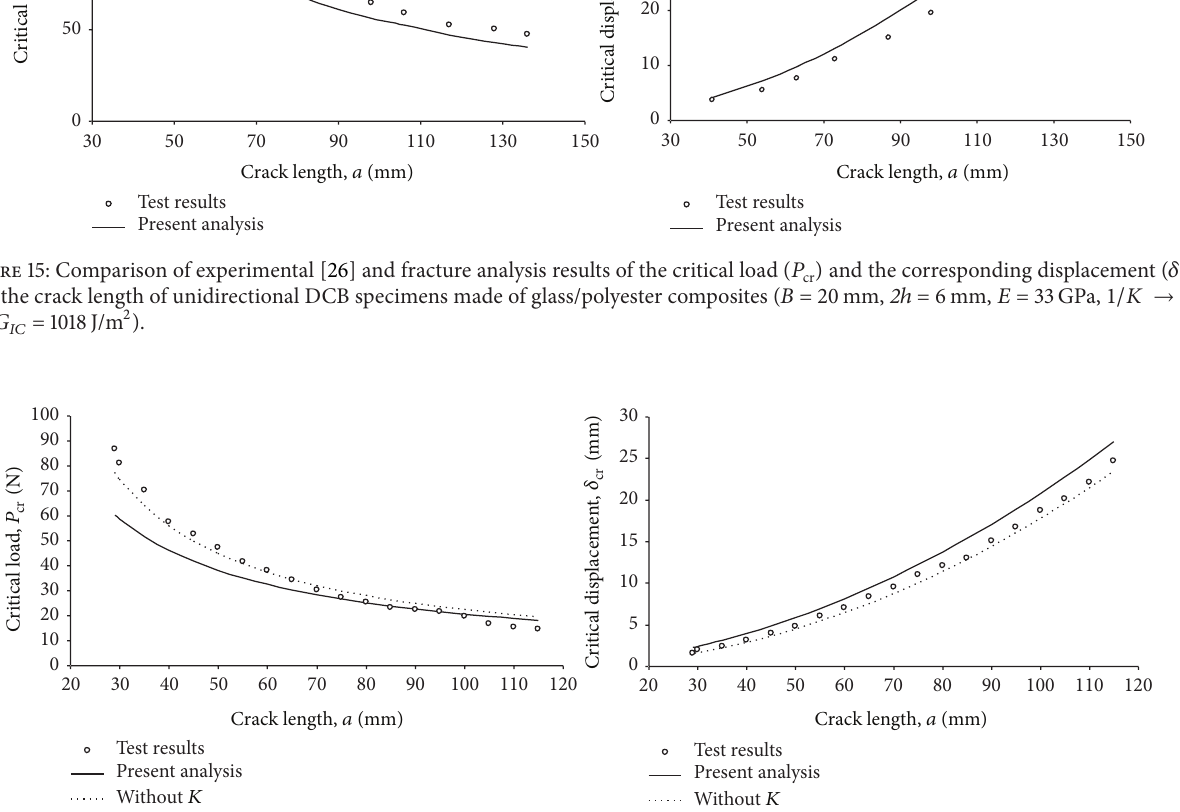
Figure 16: Comparison of experimental [27] and fracture analysis results of the critical load (𝑃 with the crack length of DCB specimens made of carbon/epoxy (XAS-913C, Ciba Geigy plc) composites (lay-up: [0 ∘ ] 24 , 𝐵 = 20 mm, 2 ℎ = 3 mm, 𝐸 = 150GPa, 𝐾 = 90.4 Nm, and 𝐺 𝐼𝐶 = 297 J/m 2